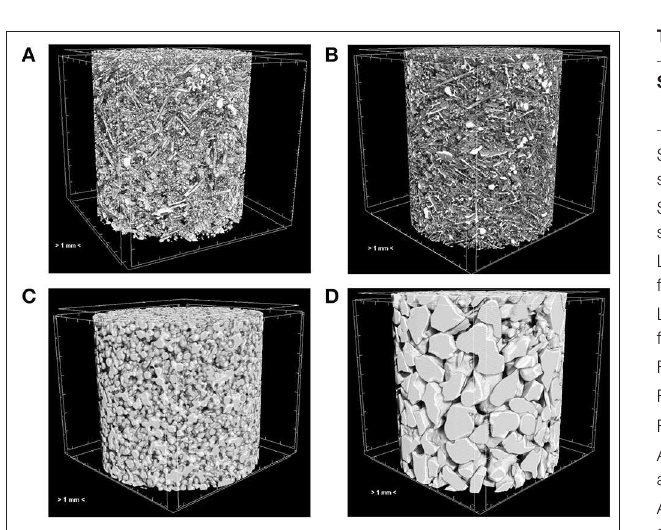
FIGURE 5 | 3D binary reconstructions of µ CT data for (A) fresh snow (FSB), (B) snow aged 1 day (ASA), (C) small grained artificial snow (SGB), and (D) large grained firn (LGA). Samples (A,B) are 170mm in height and diameter; samples (C,D) are 220mm.